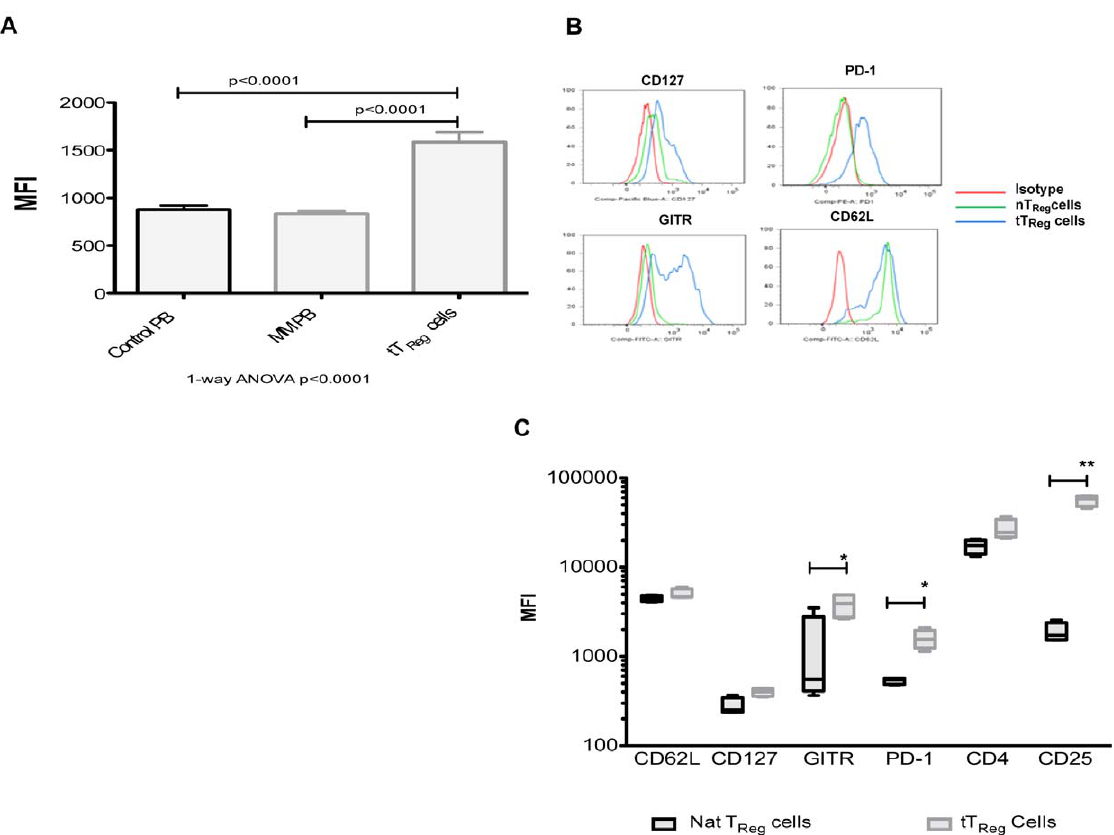
Figure 2. Phenotypic characteristics of tumour-induced regulatory T-cells. A. FoxP3 expression, as determined by mean fluorescence intensity (MFI) in natural T Reg cells from healthy controls (Control PB, n=43), PB from patients with MM (MM PB, n=43) and tT Reg cells (n=15) generated in co-culture from CD4 + CD25 - T-cells (Kruskal-Wallis test). Results represent all experiments, expressed as mean 6 SEM and analyzed using a 1-way ANOVA and student t-test. B. Representative histograms of naturally occurring T Reg cell and tT Reg cell surface expression of CD127, PD-1, GITR and CD62L. C. Summary of surface expression profiling of natural T Reg cells and tT Reg cells generated in co-culture, gated on FoxP3 + CD25 + CD4 + T-cells (n=4), expressed as mean fluorescence intensity (MFI). Results represent all experiments, expressed as mean 6 SEM and analyzed using student t- test (*p , 0.003, **p , 0.0001).